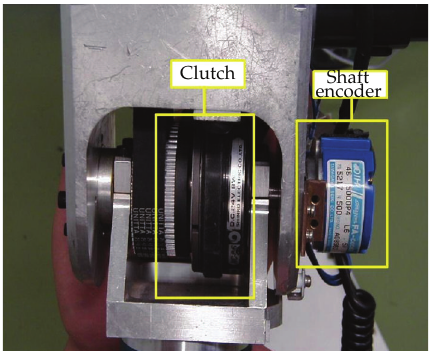
Figure 1: The hybrid